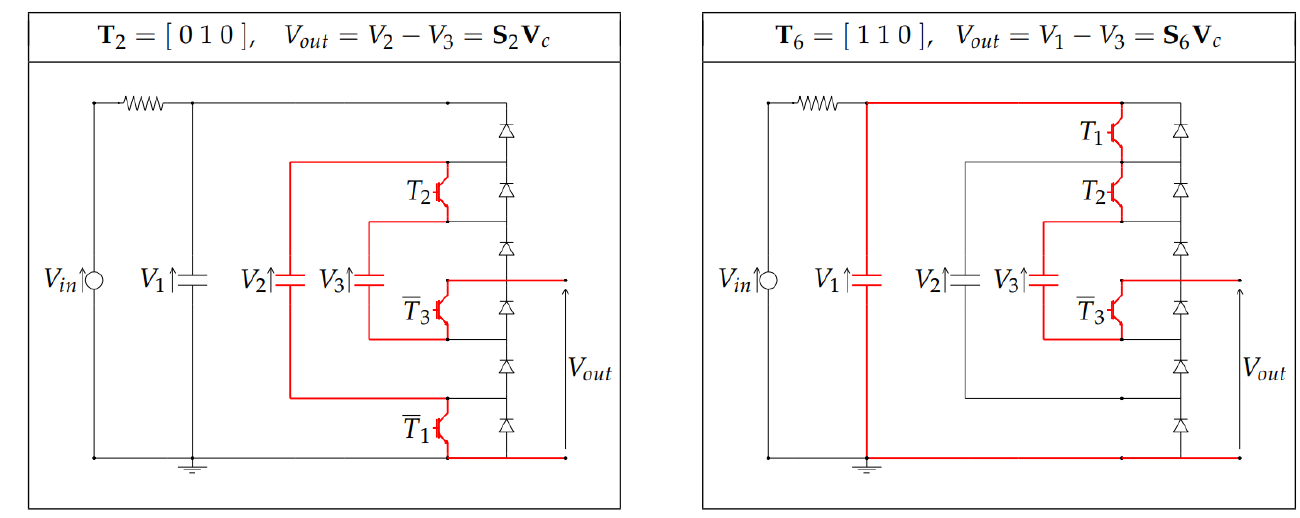
Figure 3. Electrical schemes showing how the output voltage V out is obtained as a function of the Insulated Gate Bipolar Transistors (IGBTs) signal vectors T i in the two cases T j = T 2 = [ 0 1 0 ] and T j = T 6 = [ 1 1 0 ].